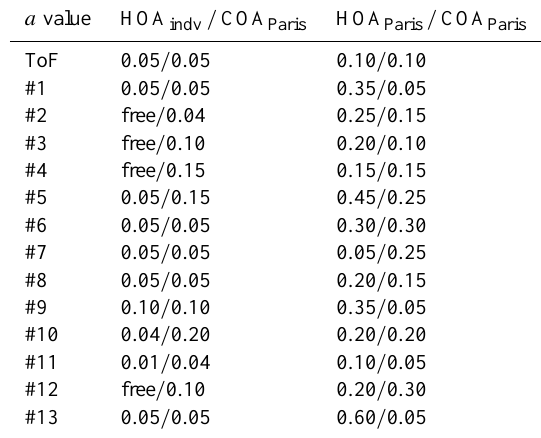
Table 2. a values of the best solutions for each instrument. Anchors used in the ME-2 analysis: HOA anchor left table column: individ- ual reference spectra from previous unconstrained PMF solution of the same data set (HOA indv ), right table column: HOA Paris , COA anchors left and right table columns: COA Paris . In some cases (#2, 3, 4 and 12) the time series correlation with external tracers was better (higher R 2 ) without constraint of the HOA